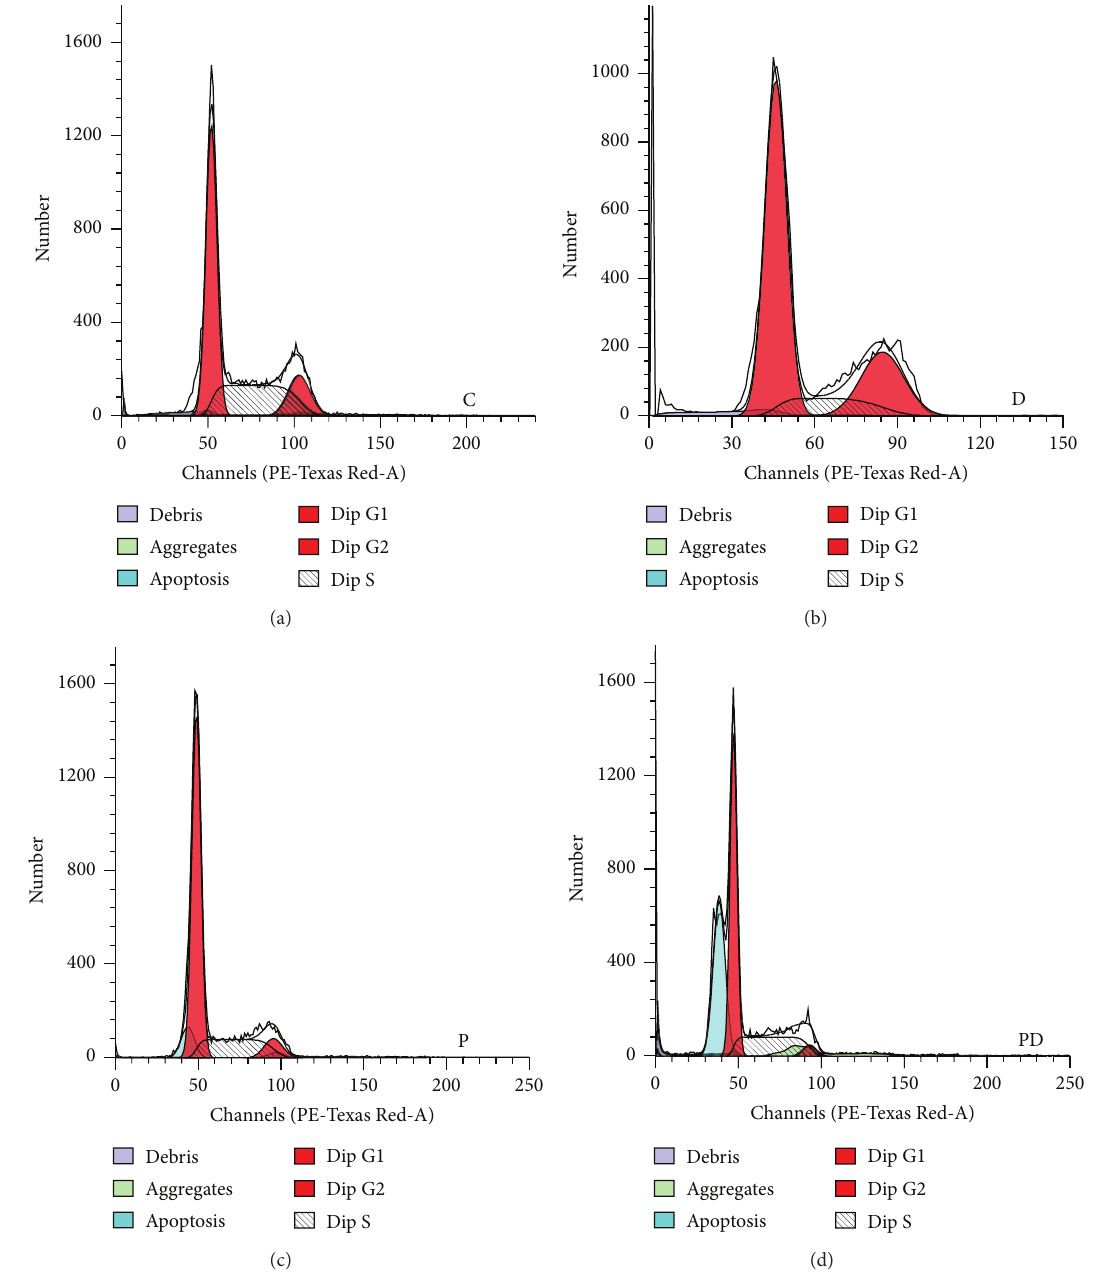
Figure 5: Analysis of cell cycle progression in MDA-MB-231 breast cancer cells. MDA-MB-231 cells were subjected to (1) control conditions (C), (2) 2.5 𝜇 M doxorubicin (D), (3) 30 nM Per2 esiRNA (P), and (4) 30 nM Per2 for 48 hours + 2.5 𝜇 M Dox for 24 hours (PD). Cell